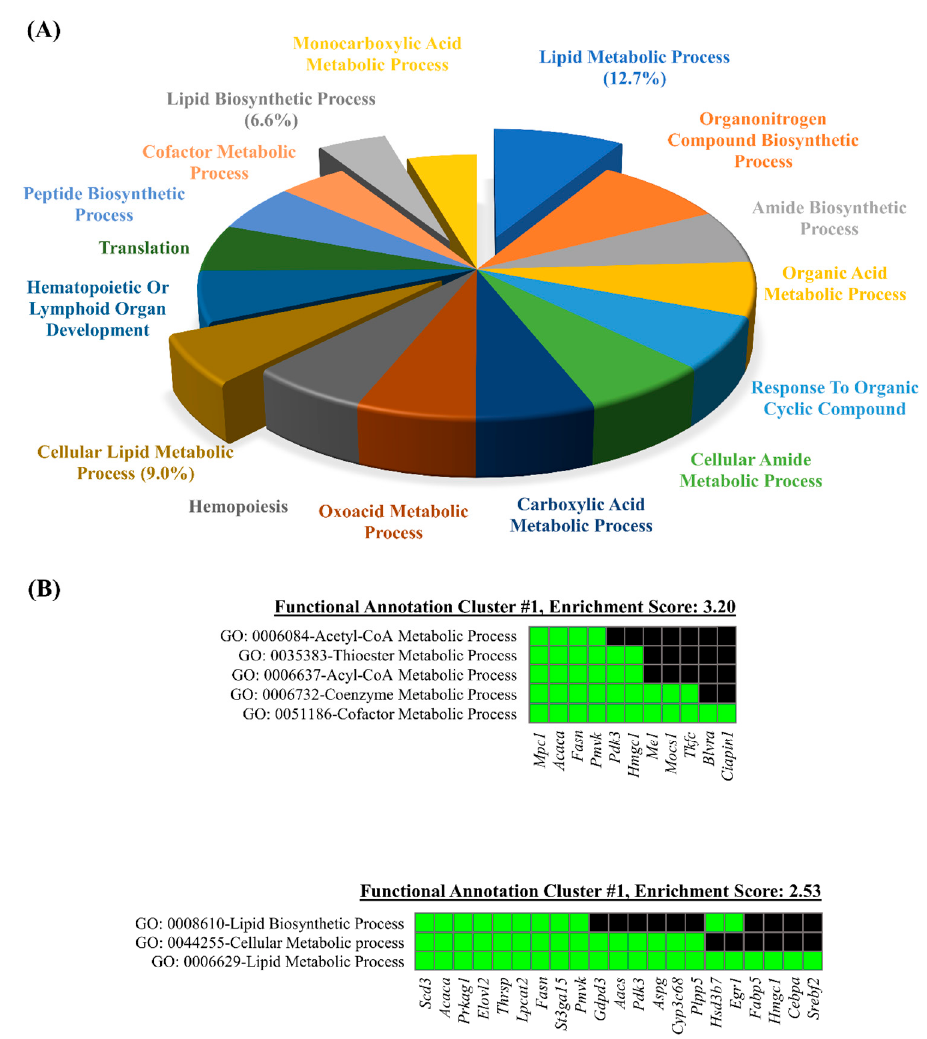
Figure 5. Functional analyses of differentially expressed genes by DAVID gene ontology (GO) enrichment analysis. The representative GO terms for biological processes ( A ) were utilized for DAVID functional annotation clustering of categories ( B ).